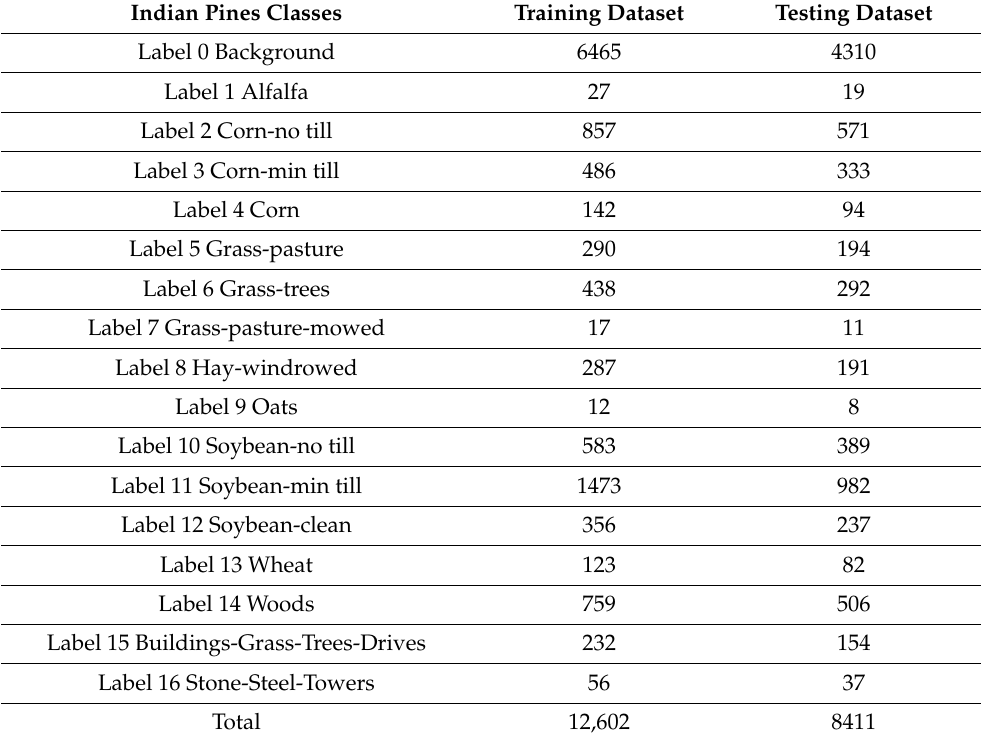
Figure 5. Indian Pines hyperspectral image: ( a ) Original Indian Pines data cube (145*145*224). ( b ) The Indian Pines ground truth image. ( c ) The training region of interest (ROI). ( d ) The classification legend for different classes. Table 1. Indian Pines hyperspectral dataset.